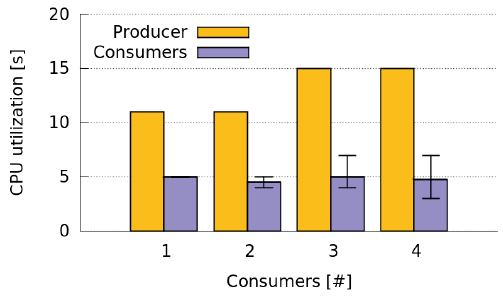
Figure 19. Producers and Consumers CPU utilization when sharing GPS data periodically (low data transmission rate).